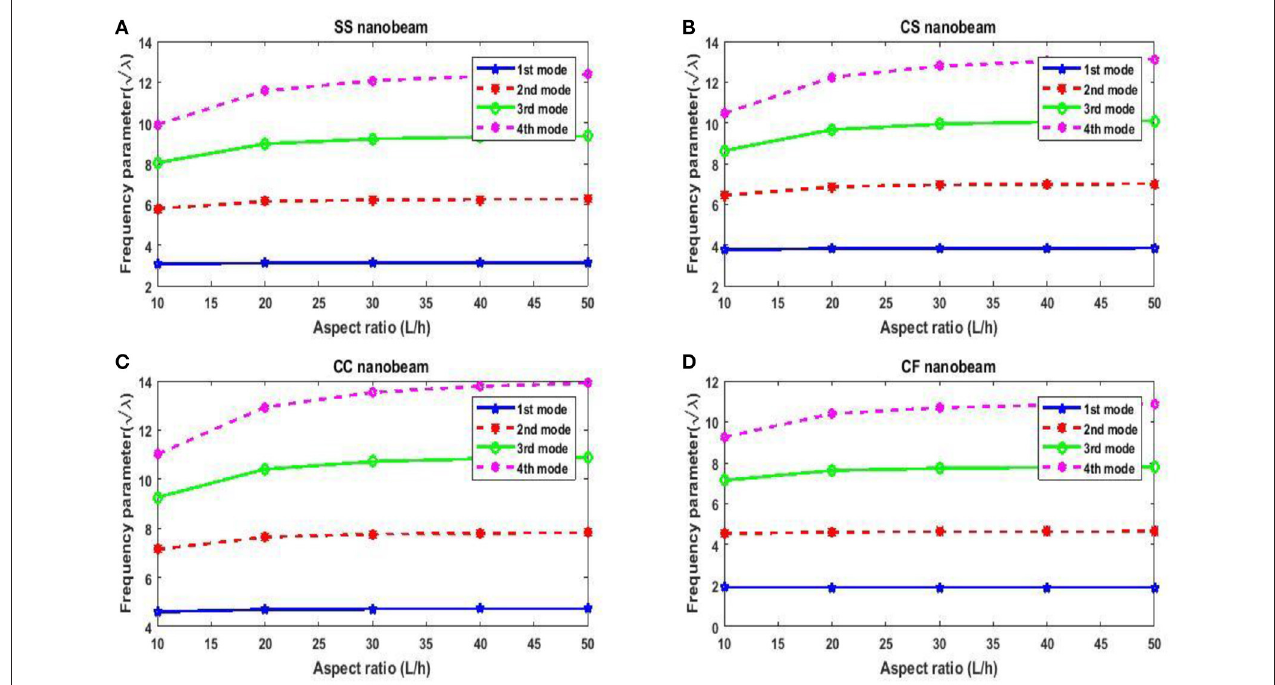
FIGURE 4 | Variation of frequency parameter with length-to-height ratio. (A) Variation of L/h for SS Nanobeam. (B) Variation of L/h for CS Nanobeam. (C) Variation of L/h for CC Nanobeam. (D) Variation of L/h for CF Nanobeam.